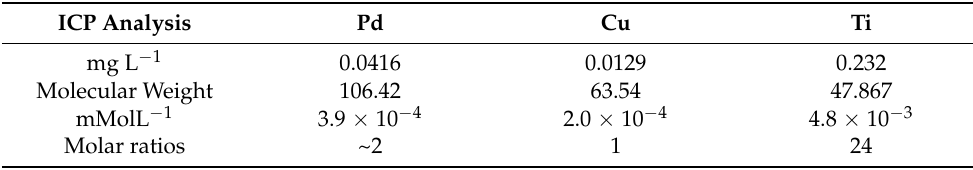
Figure 2. ( a – c ) low and high magnified TEM images, ( d ) lattice fringes, ( e ) SAED patterns, ( f ) EDX spectra, ( g – j ) mapping of Pd 2 Cu/P25 (Elements: Pd ( g ); Cu ( h ); Ti ( i ); O ( j )). Table 1. ICP-AES results of Pd 2 Cu/P25